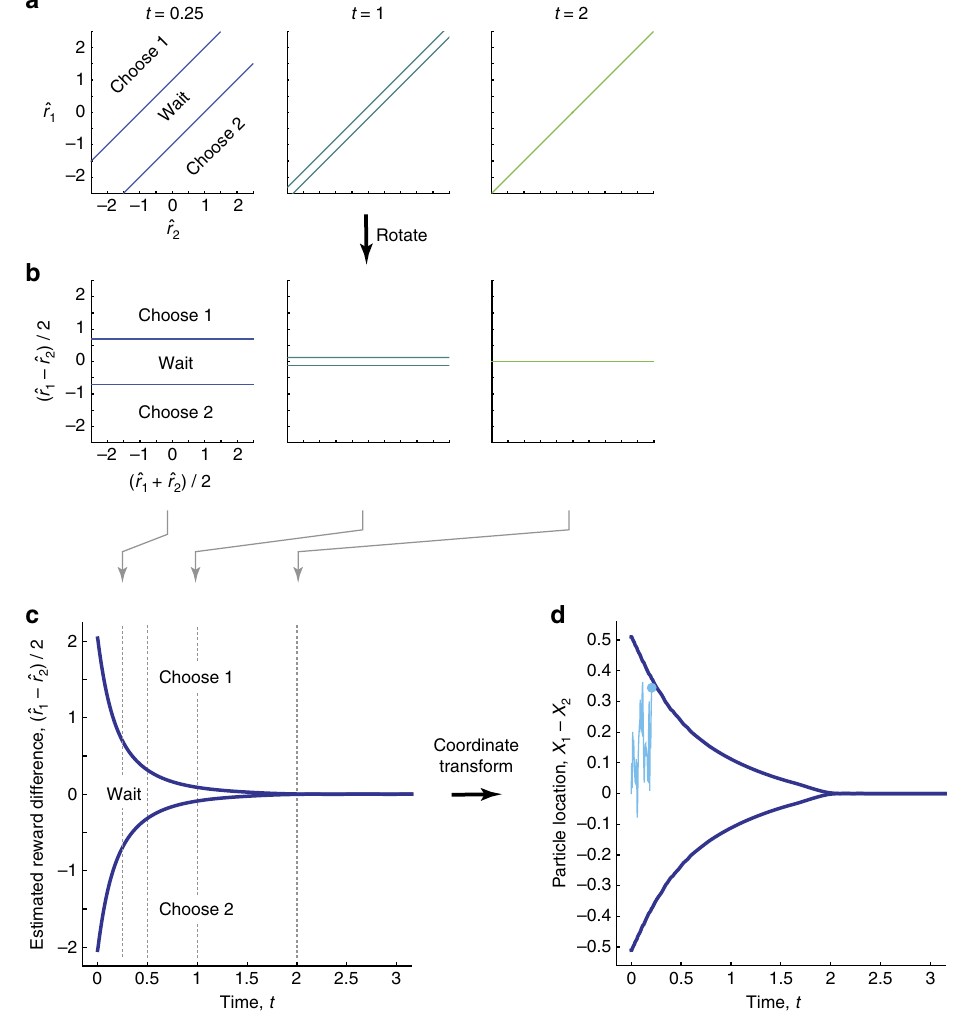
Figure 4 | Optimal decision boundaries computed numerically by DP. ( a ) The decision boundaries and choices at three representative time points ( t ¼ 0.5, 1 and 2s), shown in the space of reward estimates ^ r 1 ; ^ r 2 ð Þ . ( b ) The same as a , but shown in a rotated space, ð ^ r 1 þ ^ r 2 ; ^ r 1 (cid:3) ^ r 2 Þ . ( c ) The decision 2 2 , as functions of time. The distance between boundaries decreases as time elapses, and boundaries in terms of the expected reward difference, ^ r 1 (cid:3) ^ r 2 2 collapses to zero at some point. ( d ) The same decision boundaries shown in the space of accumulated evidence, which is represented by the particle location in a DDM. The cyan trace is a sample particle trajectory, representing evidence accumulation and the subsequent choice of option